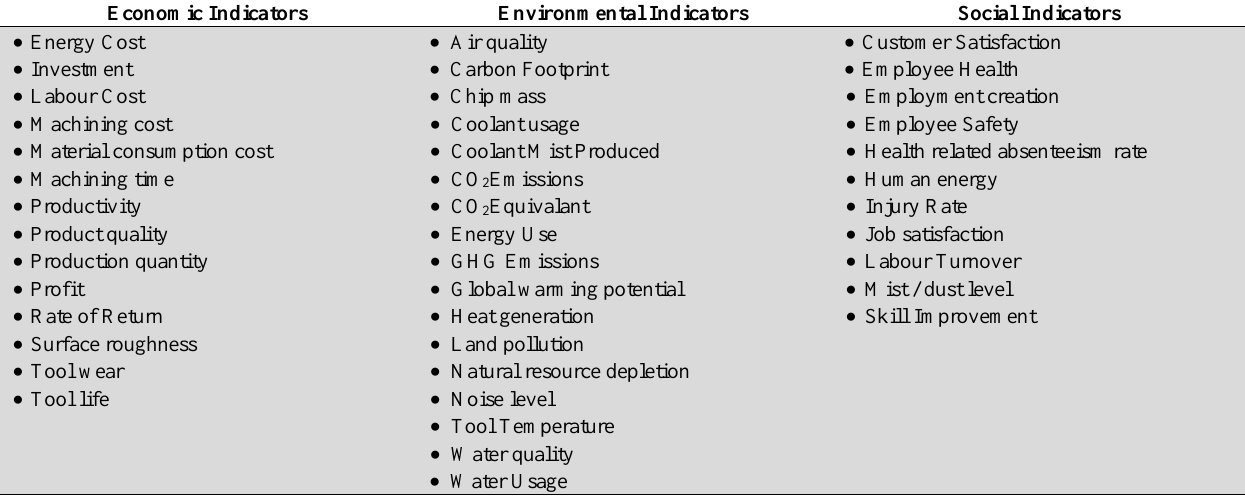
Typical Indicators used by various researchers for sustainability